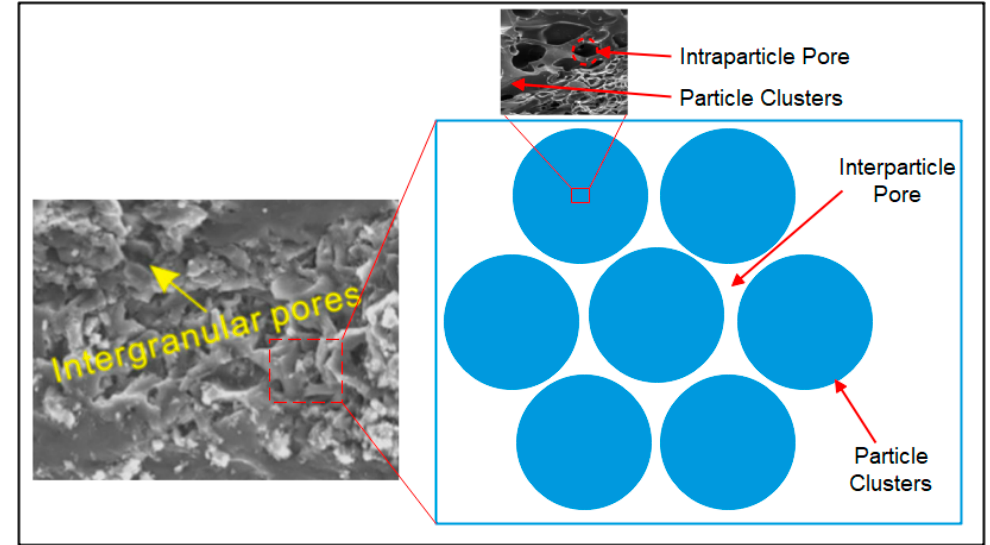
Figure 1. Schematic of the bi-dispersed porous structure of the coal matrix. Note that the scanning electron microscope (SEM) image of coal is copied from reference [39].